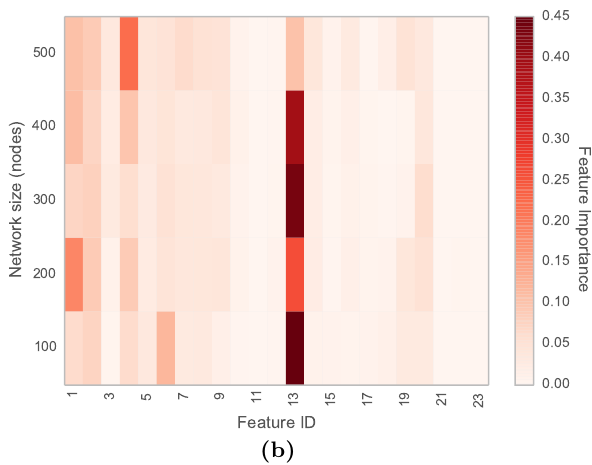
Figure 5: (a) Feature significance in all the networks at 60% loss for model with all 38 features. (b) Fea- ture significance of connected feed-forward loop mo- tifs in all the networks at loss 60%. The darker the color the higher the feature significance . Addition- ally, numbers are included to indicate feature